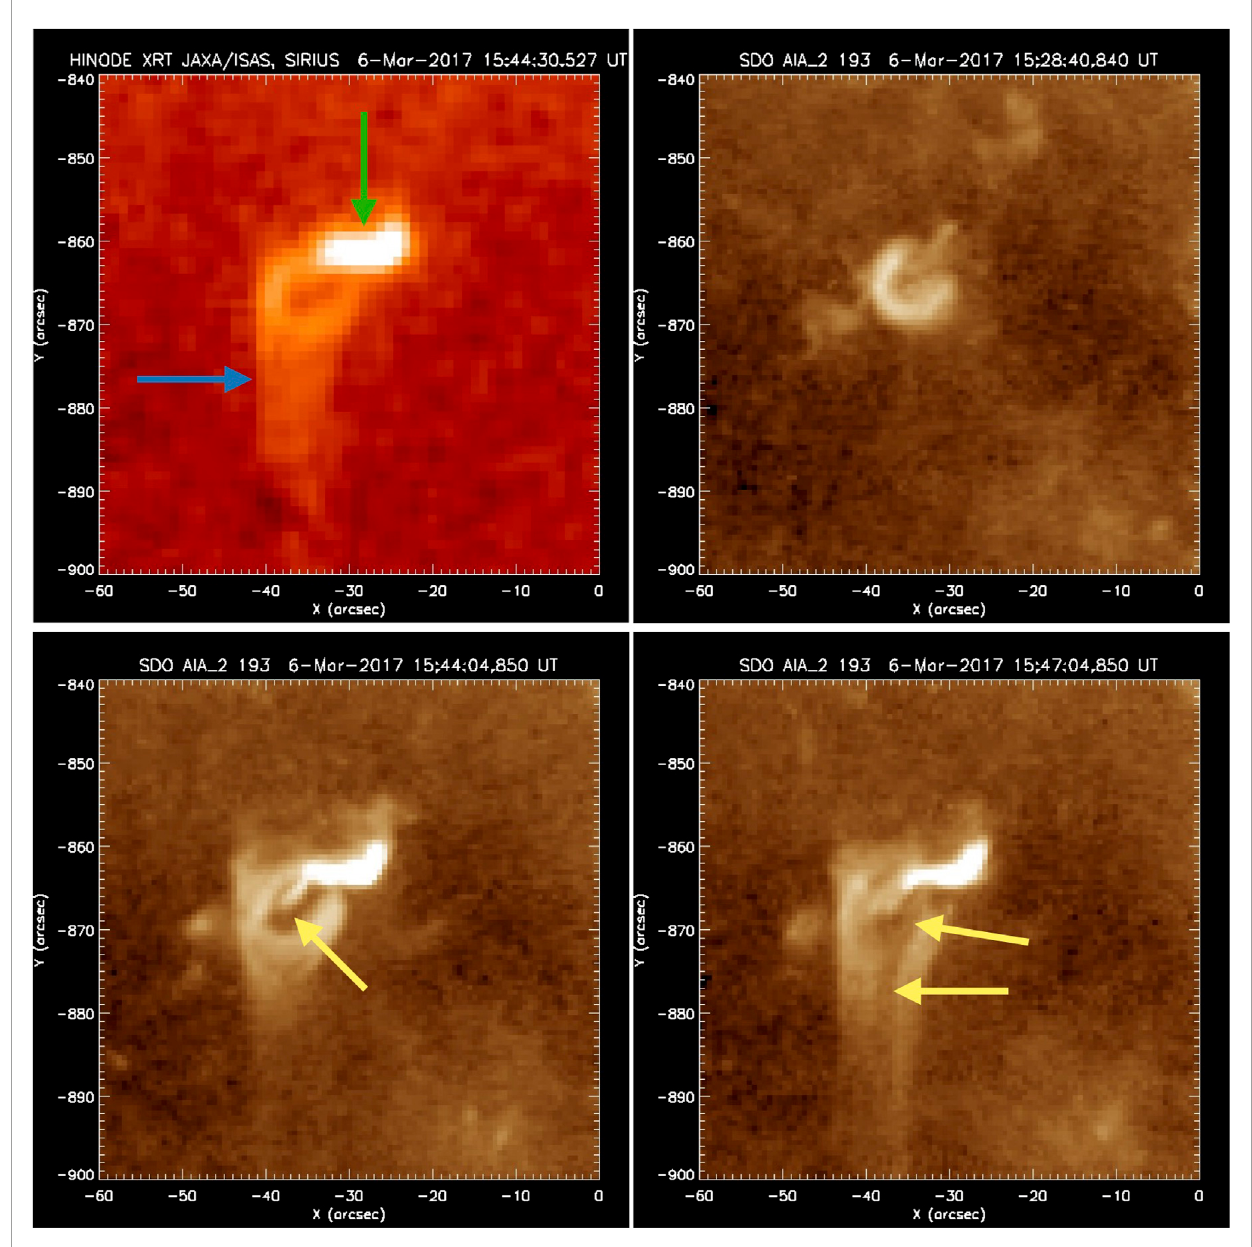
FIGURE 1 Example of a coronal jet, occurring on 2017 March 6. (a) Hinode /XRT soft X-ray image of the coronal-jet spire (blue arrow) and the jet bright point (“JBP”) brightening in the coronal-jet’s base (green arrow). North is upward and west is to the right in this and all solar images in this paper. This coronal jet is in the south polar region, and hence the spire is pointing